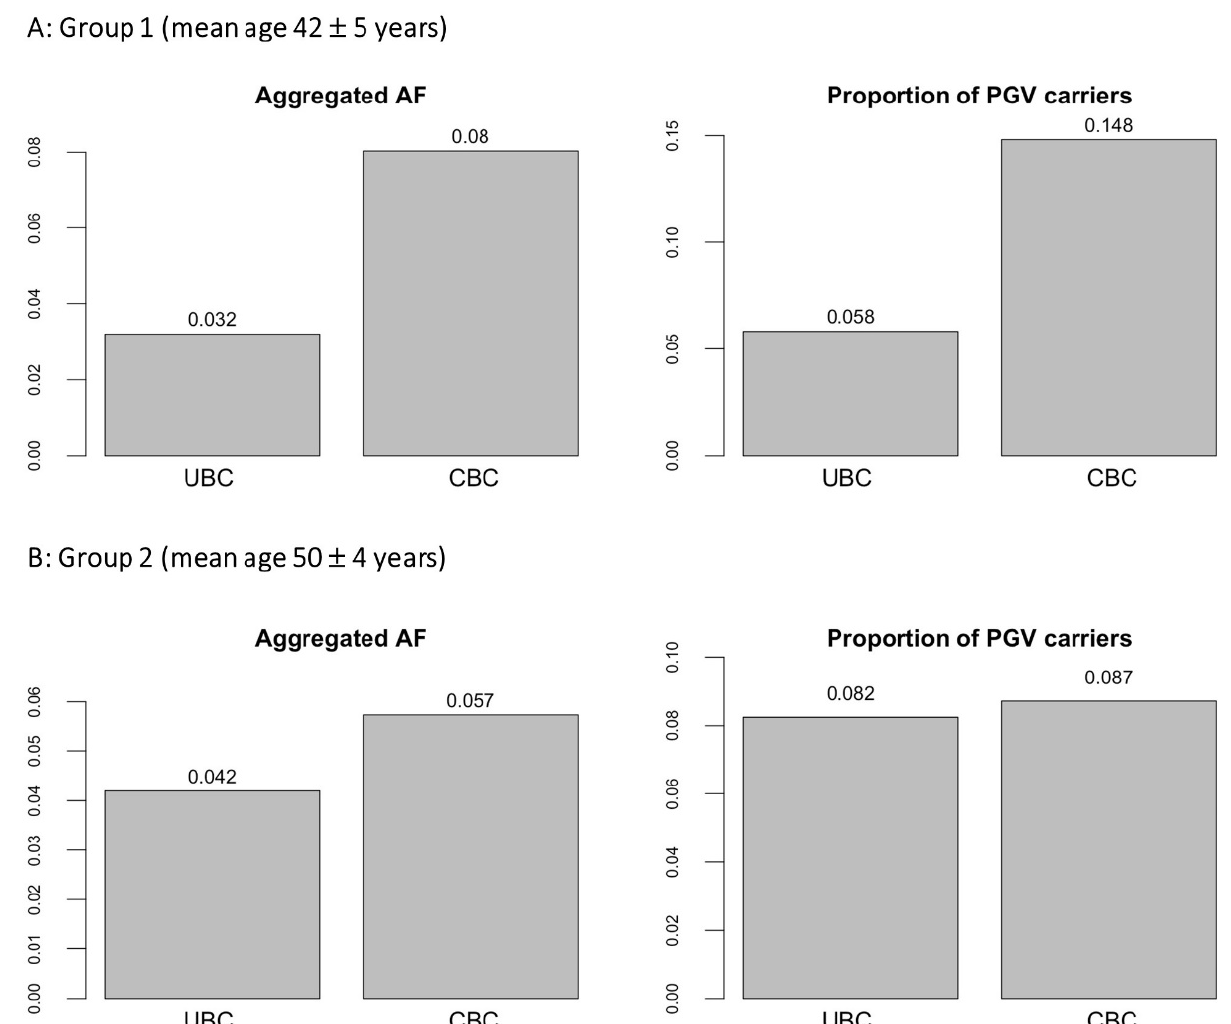
Figure 1. Burden of PGVs in Group 1 and Group 2. Figure notes: In Group 1, the PGVs burden in CBC is significantly higher than in UBC (Burden SKAT test p = 0.002). Differences between CBC and UBC in Group 2 are not statistically significant (Burden SKAT test p = 0.42). Aggregated ALT allele frequency (aggregated AF) was calculated as the total count of ALT alleles (aggregated AC) over the mean allele number (mean AN) across the aggregated variants. The proportion of PGVs carriers was calculated as the fraction of participants carrying at least one variant in question (homo- or heterozygous). PGV: pathogenic germline variant.